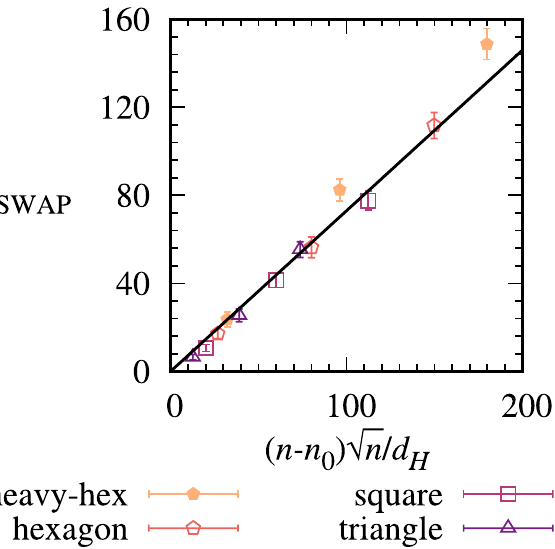
Figure 3. Average SWAP gate scaling with number of qubits n and hardware degree d H for 3-regular